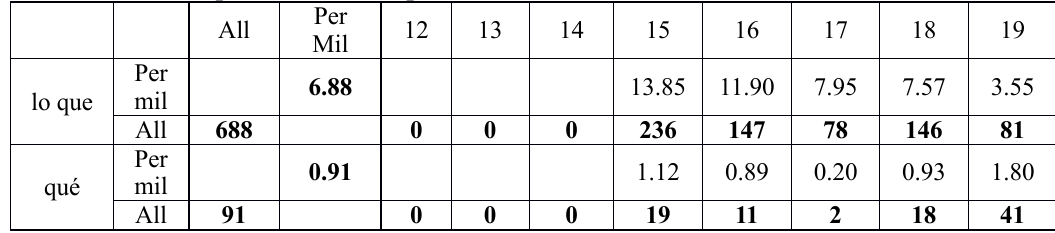
Table 5: decir qué vs. decir lo que All